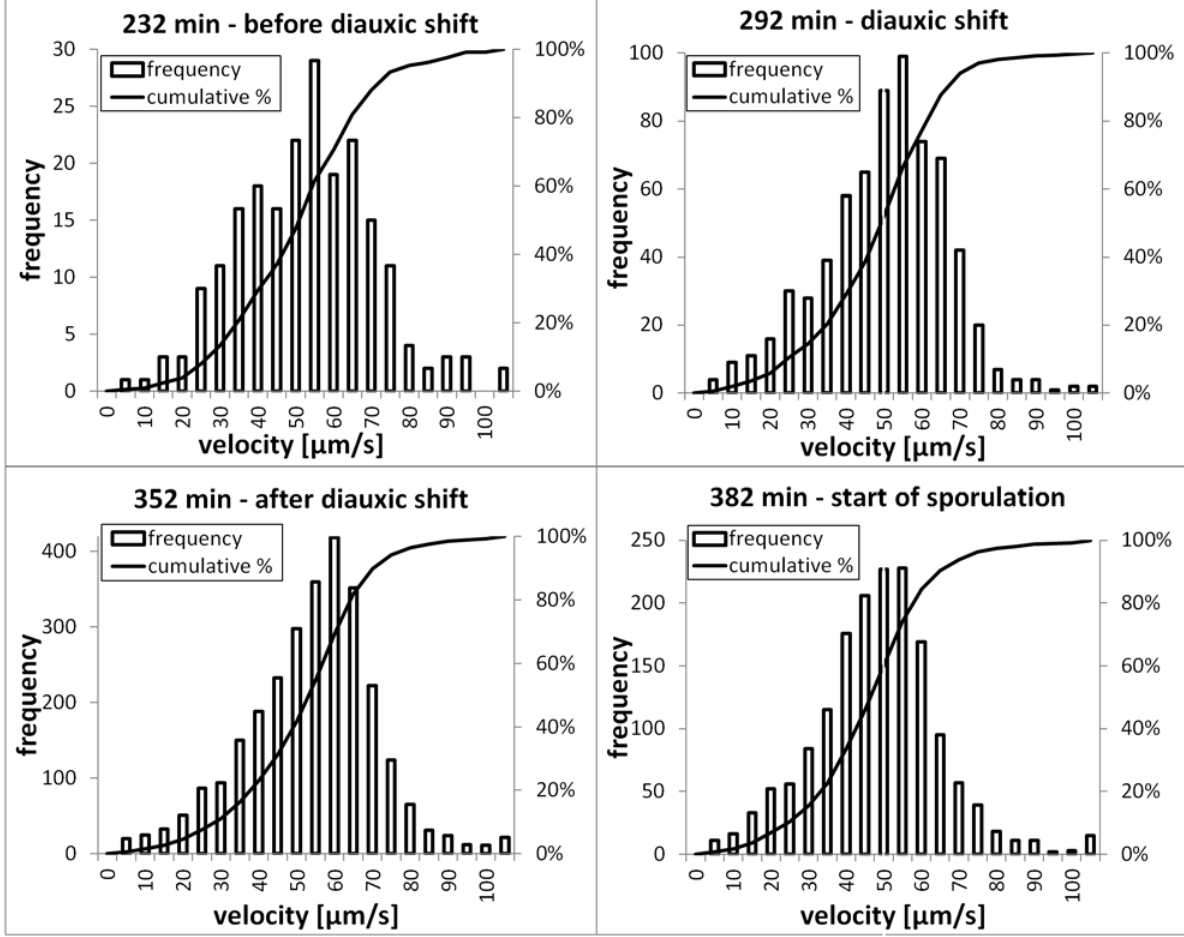
Fig 8. Histograms of individual velocities. The Histograms produced by automatic image analysis on the four significant sampling points of interest (before diauxic shift, diauxic shift, after diauxic shift, start of sporulation) during fermentation 1.